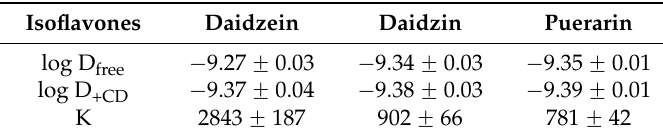
Table 3. Diffusion coefficients (D) in D 2 O and association constants (K), log D free (isoflavones alone